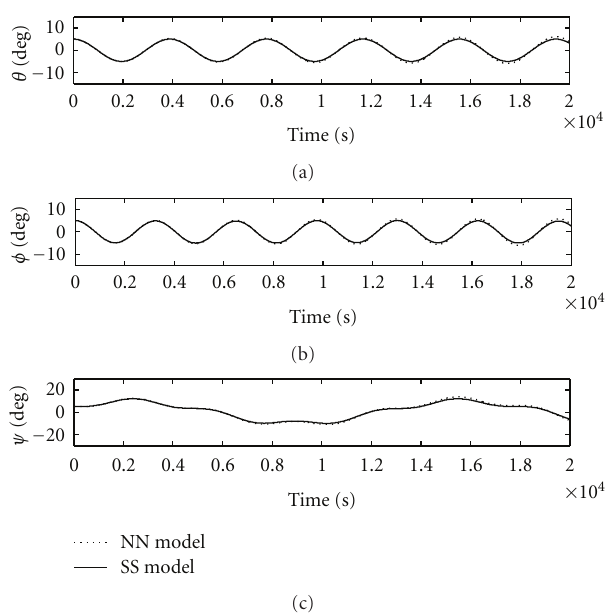
Figure 9: NN versus state-space models for satellite